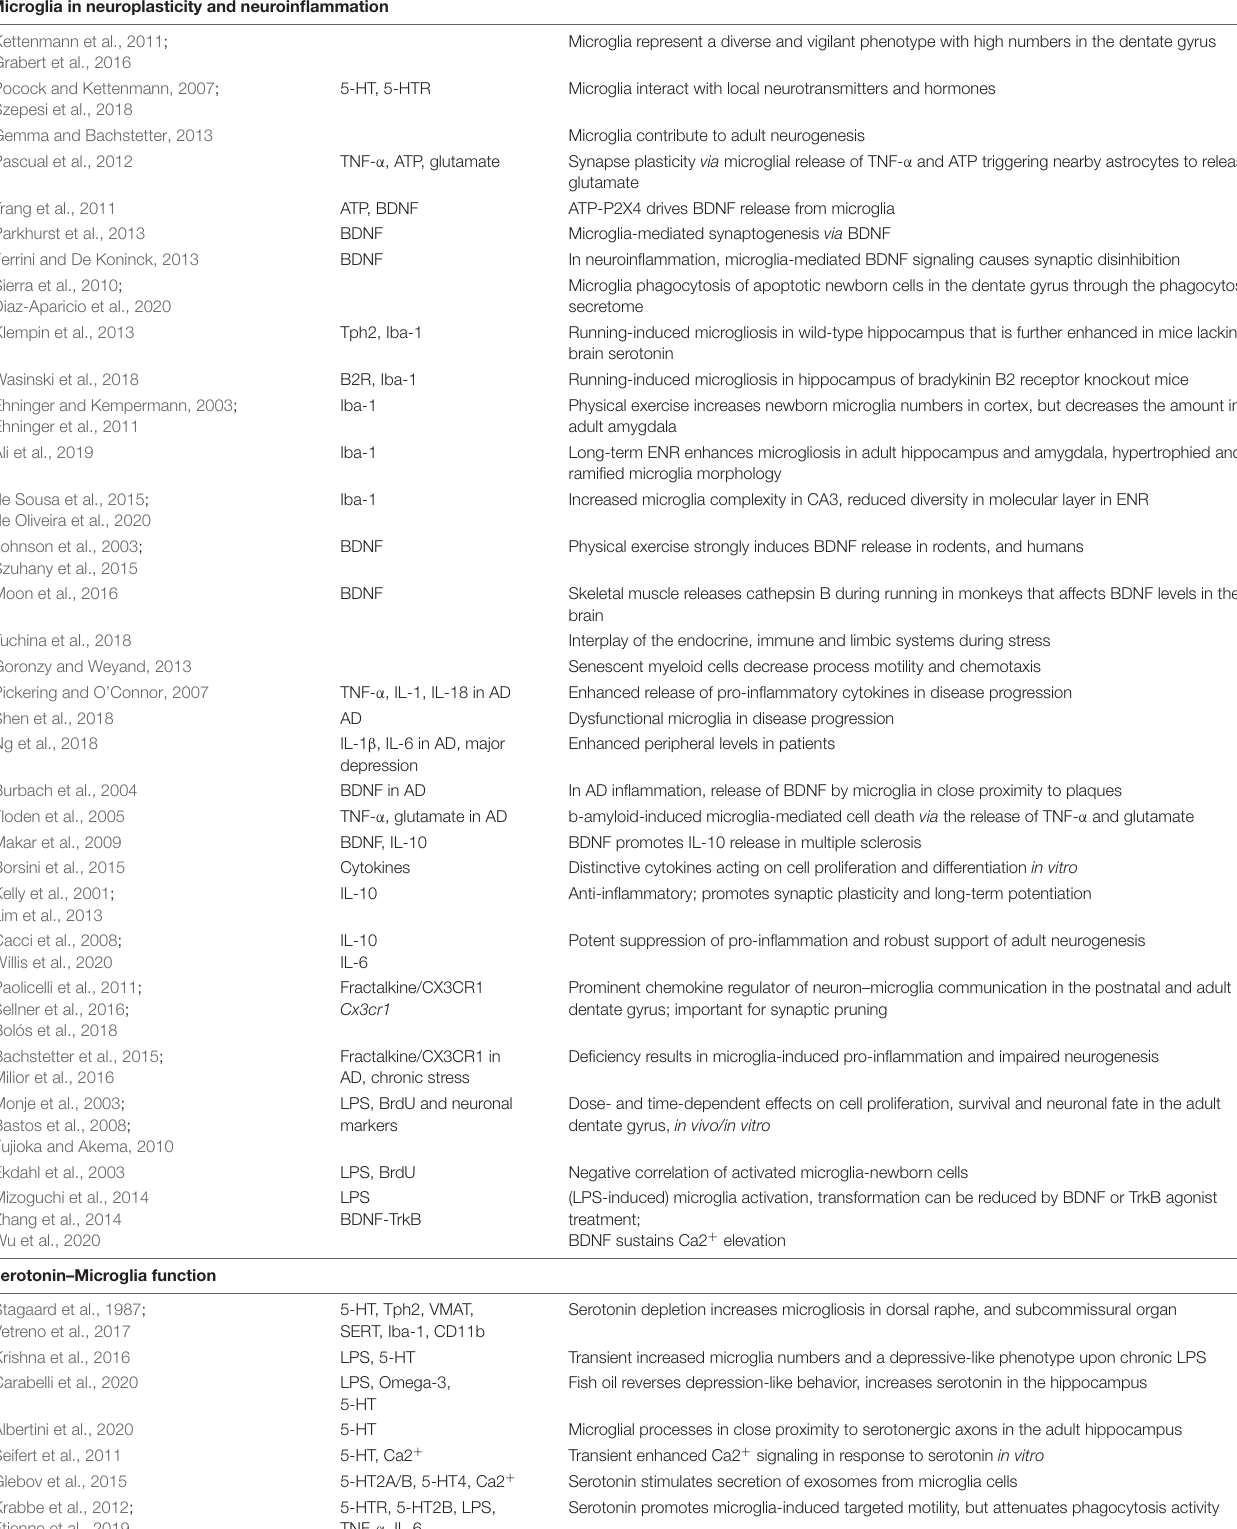
TABLE 1 | Summary of recent findings on microglia function in neuroplasticity and neuro-inflammation in the hippocampus, with focus on serotonin and antidepressant